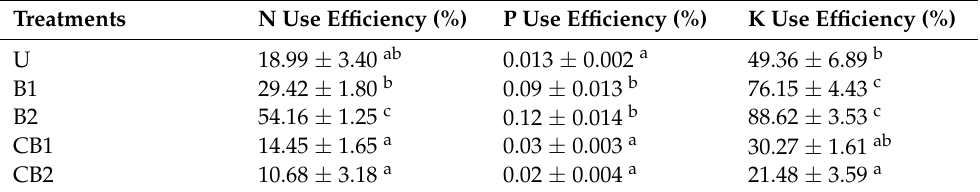
Table 11. Effects of rice straw biochar on N, P, and K use efficiency of rice plant MR297 cultivar.